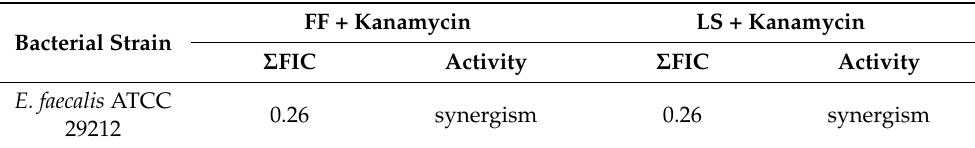
Table 2. Fractional inhibitory concentration (FIC) index results obtained with FF or LS and kanamycin combinations by checkerboard method.